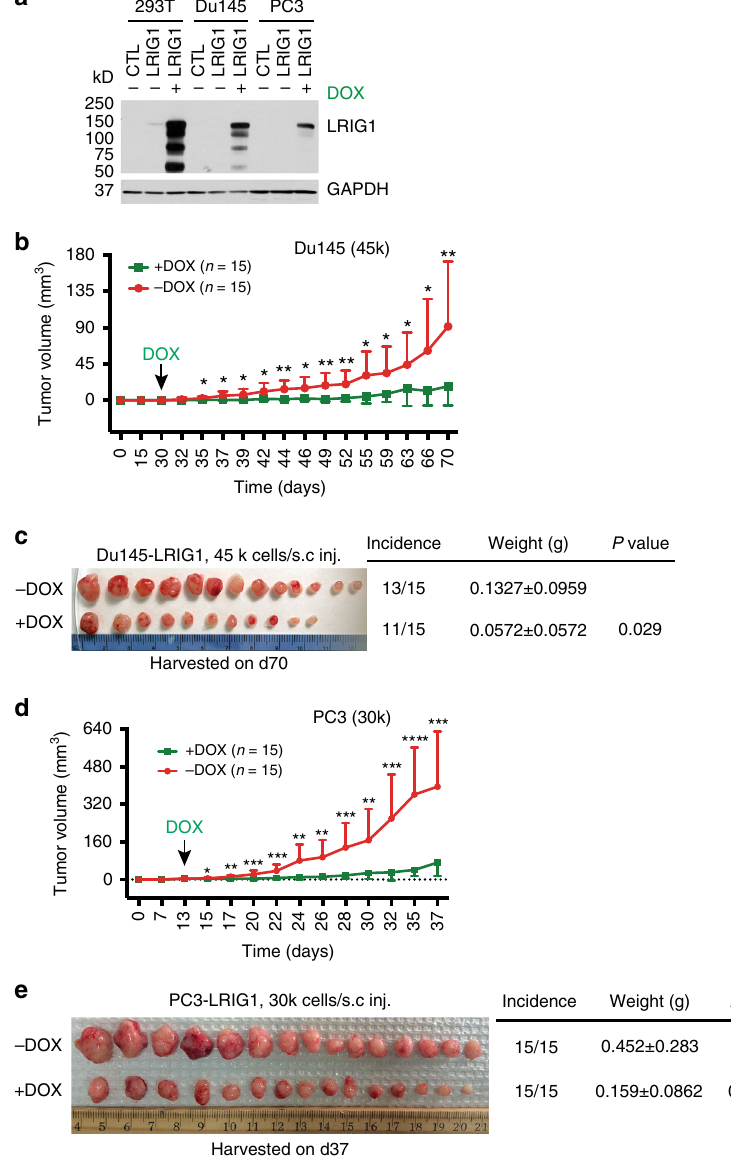
Fig. 6 Inducible LRIG1 expression inhibits pre-established AR − PCa xenografts. a Establishing doxycycline (DOX) inducible LRIG1-expressing PCa cell models. The AR - Du145 and PC3 cells (293T, control cells) were infected with the pLVX-TetOne-LRIG1-Puro lentivirus (MOI 10; Supplementary Fig. 5d) for 72 h followed by puromycin selection (~2 weeks). Cell lysate prepared from cells in the absence or presence of DOX (0.1 μ g/ml; 48 h) were used in Western blotting analysis of LRIG1 (GAPDH was used as control). b , c LRIG1 induction inhibits growth of pre-established Du145 xenograft tumors. Du145 cells were implanted subcutaneously (s.c; 45,000 cells/injection) in NOD/SCID mice and, 30 days later, DOX was added to the food (2 mg/kg body weight; arrow) of one group of animals ( n = 15 for each group). Tumor volume was measured ( b ; * P < 0.05, ** P < 0.01, two-tailed unpaired Student ’ s t - test). c Animals were terminated on day 70 post implantation and shown are tumor images, tumor incidence, endpoint tumor weights (mean± SD), and the P value (Student ’ s t -test). d , e LRIG1 induction inhibits growth of pre-established PC3 xenograft tumors. PC3 cells were implanted subcutaneously (s.c; 30,000 cells/injection) in NOD/SCID mice and, 13 days later, DOX was added to the food (2 mg/kg body weight; arrow) of one group of animals ( n = 15 for each group). Shown in d are tumor growth curves and arrows indicate the time (day) when DOX was administered (* P < 0.05; ** P < 0.01; *** P < 0.001; Student ’ s t -test). e Tumor weight and image. P -value was determined using two-tailed unpaired Student ’ s t -test. *Source data for Fig. 6a – e are provided as a Source Data fi